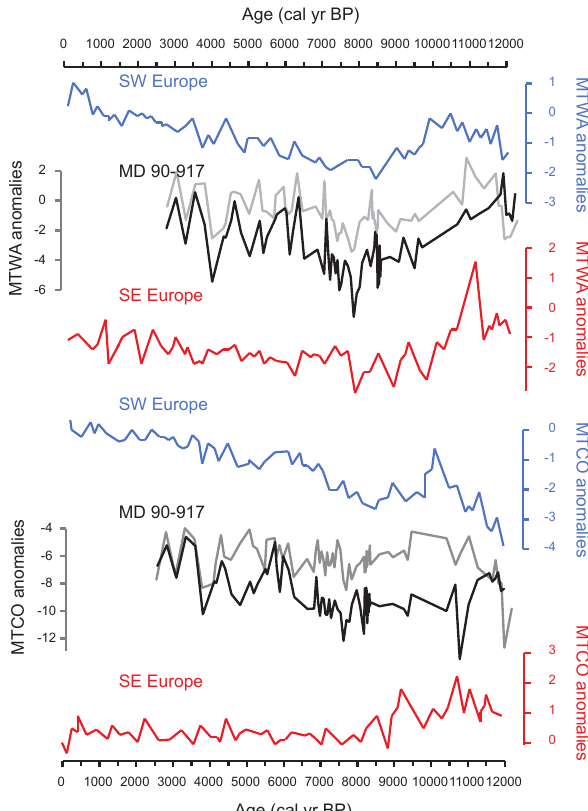
Fig. 7. Comparison between MD 90-917 pollen-based MTCO and MTWA temperature reconstructions (MAT in black, WAPLS in grey) and the combined climate records of southeastern and south- western Europe (from Davis et al., 2003). Curves are presented in temperature anomalies (reconstructed values minus present-day val-